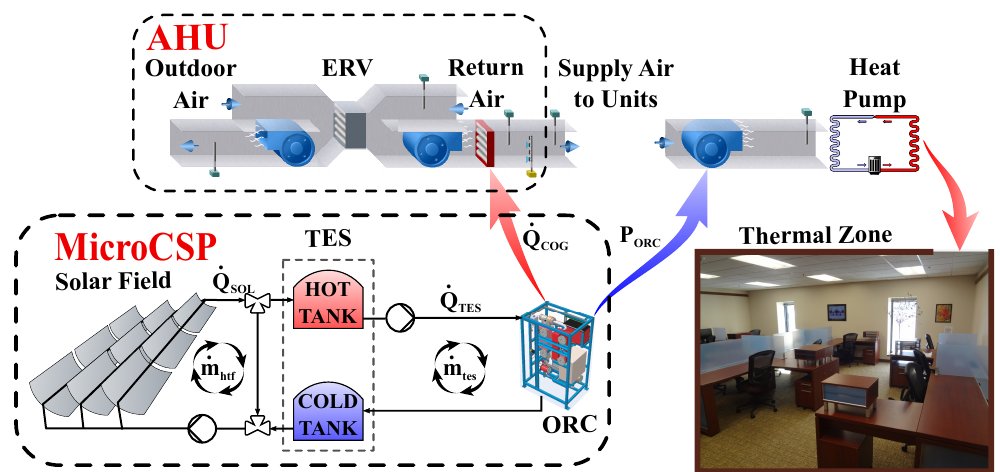
Figure 13. MicroCSP and HVAC testbed in this work. (Adapted from [17] with permission of